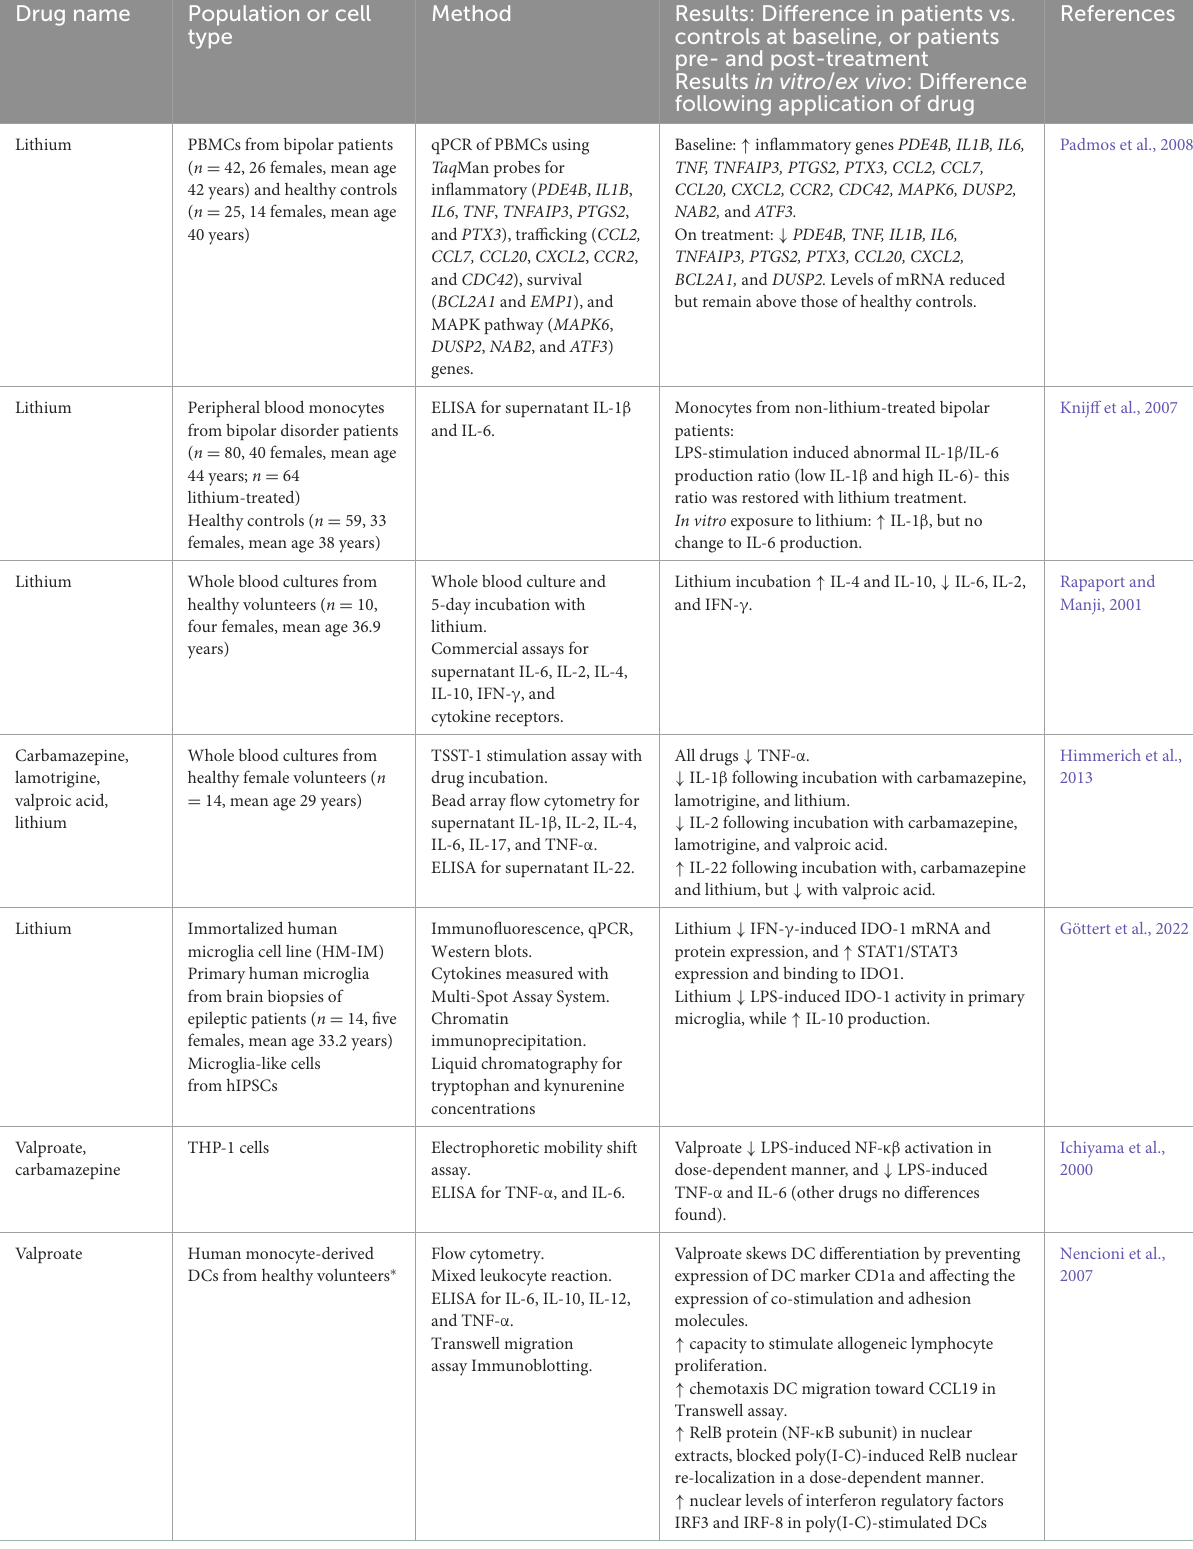
TABLE 5 Anti-inflammatory effects of mood stabilizers using in vitro or ex vivo human cells in culture or stimulation